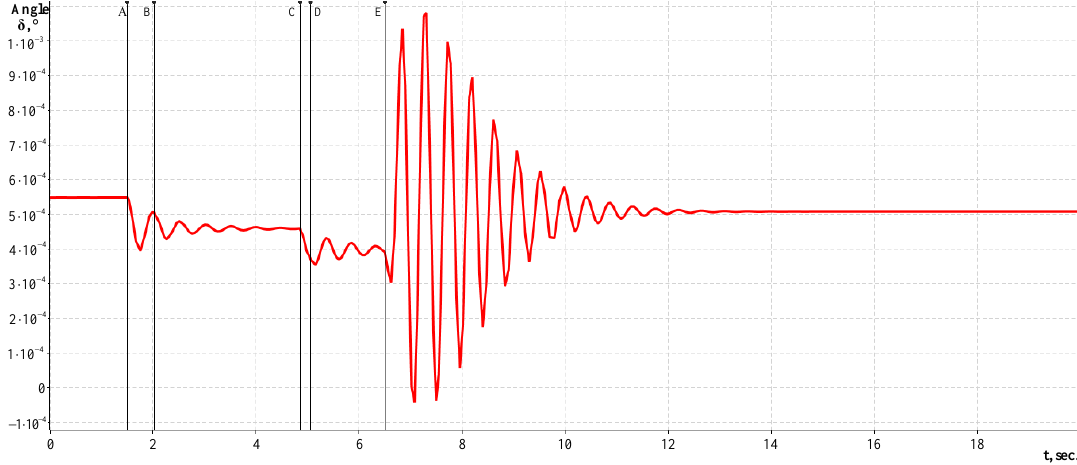
Figure 8. The angle-time curve in disturbance conditions while using the suggested method.